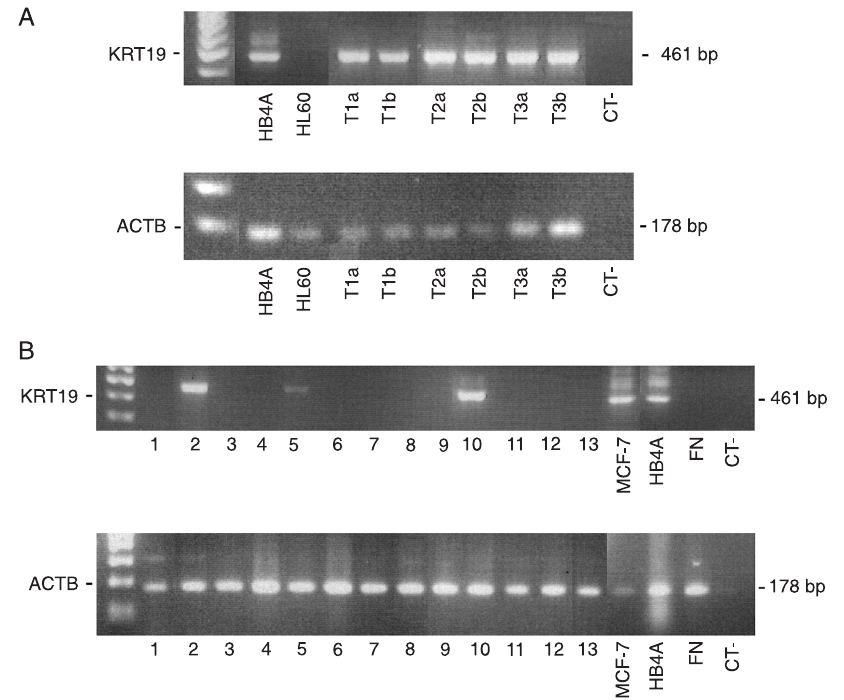
Figure 1. KRT19 detection by nested RT-PCR. A , HB4A cells [T1 (N = 2 cells); T2 (N = 5 cells); T3 (N = 10 cells] were diluted in 10 6 HL60 cells. Experiments were performed in duplicate (a and b). Epithelial cells were recovered with Dynabeads and, after nested PCR, bands of 461 and 178 bp corresponding to KRT19 and ACTB were visible. HB4A and HL60 cells were used as positive and negative controls, respectively. B , Circulating tumor cells (CT) as detected by KRT19 expression by nested RT-PCR in mononuclear cells obtained from the peripheral blood of breast cancer patients. Bands of 461 and 178 bp corresponding to KRT19 and ACTB may be seen in samples from three patients. MCF7 and/ or HB4A cells were used as positive control and a pool of lymphocytes obtained from three healthy individuals (FN), as negative